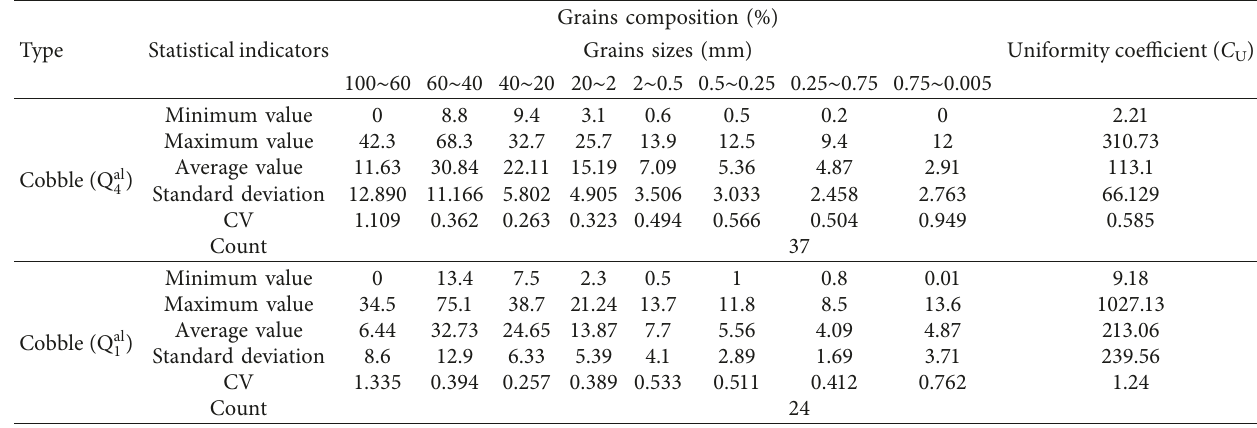
Table 1: Cobbles of particle-size